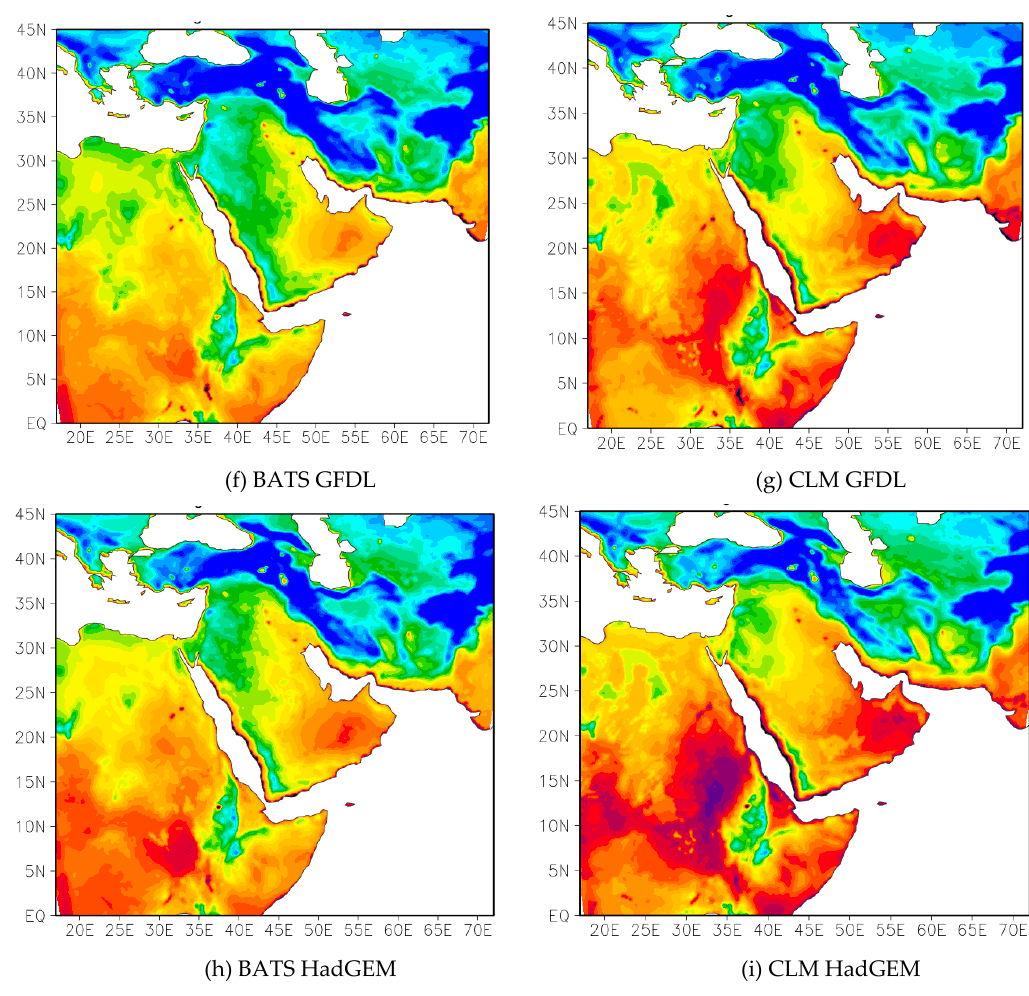
Figure 2. Spatial distribution of minimum temperature ( ◦ C) for ( a ) CRU, ( b ) ERA–Int BATS, ( c ) ERA–Int CLM, ( d ) ECHAM6 BATS, ( e ) ECHAM6 CLM, ( f ) GFDL BATS, ( g ) GFDL CLM, ( h ) HadGEM BATS, and ( i ) HadGEM CLM averaged over the period 1980 – 2005.